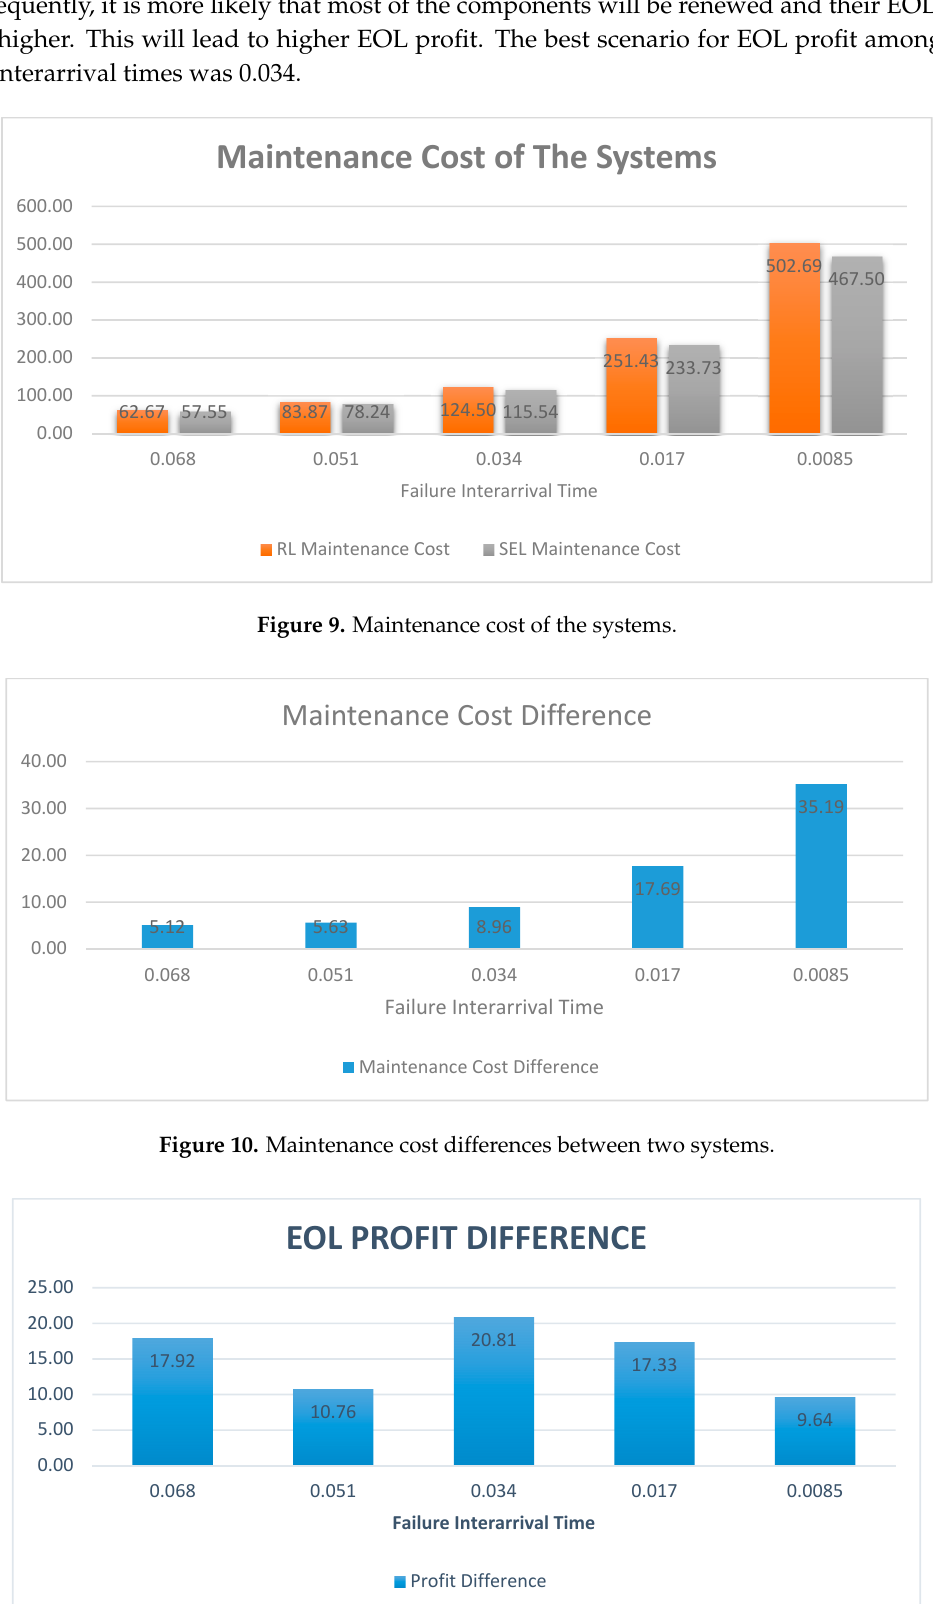
Figure 11. EOL profit difference between two systems.